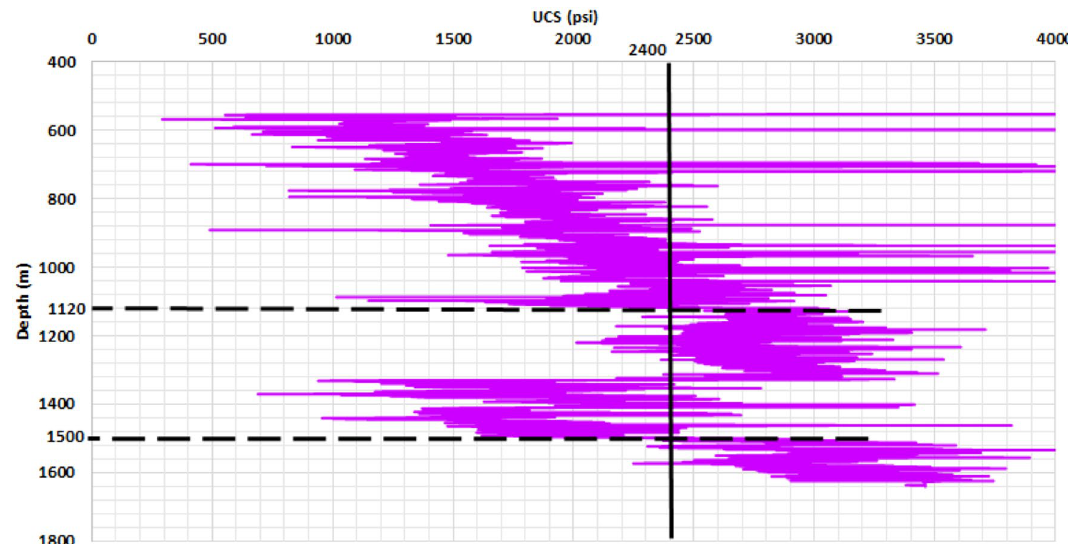
Fig. 18 UCS of Field X